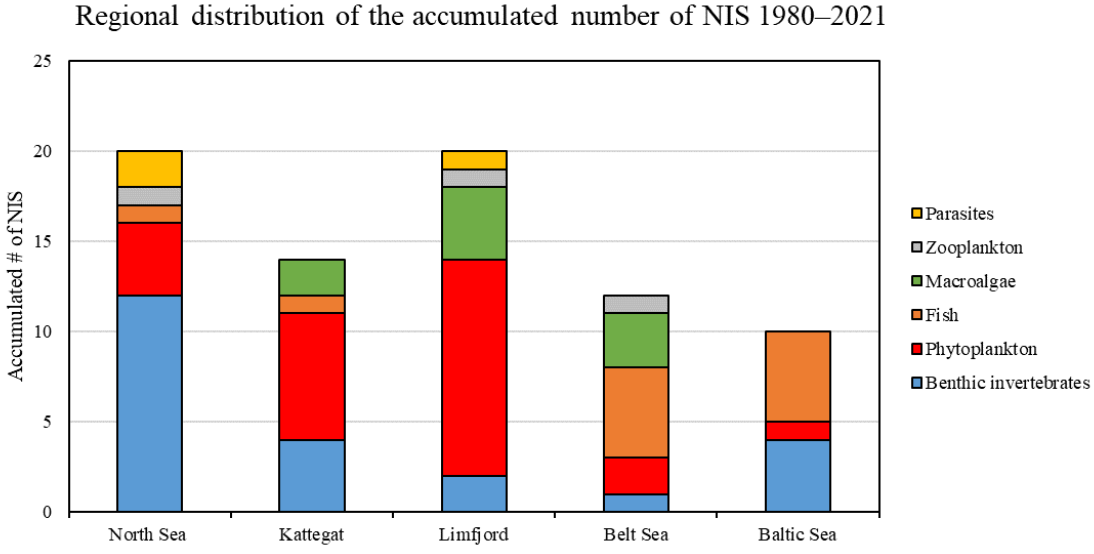
Figure 4. Sub-regional distribution of the accumulated number of NIS (first observations only) for the time period 1980 – 2021.